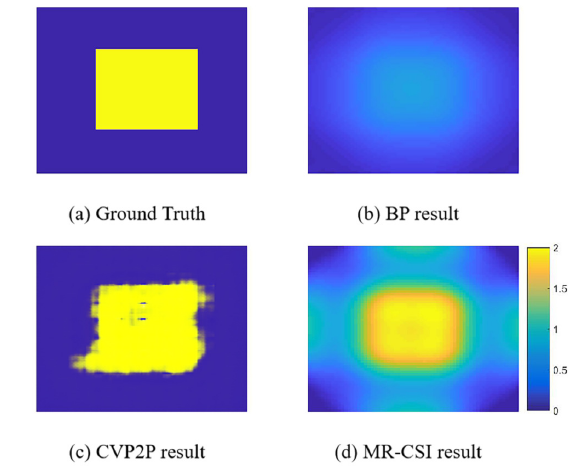
Figure 7. Experimental results reconstructed by different methods. The Ground Truth is a square wooden block with a side length of 5 cm as shown in ( a ). ( b – d ) are the reconstructed results using BP, CVP2P and MR-CSI, respectively. The CC between the image reconstructed by different methods and the ground truth is equal to 0.59792, 0.9625 and 0.8616,